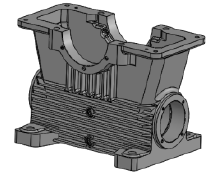
Figure 9. Lower casing.